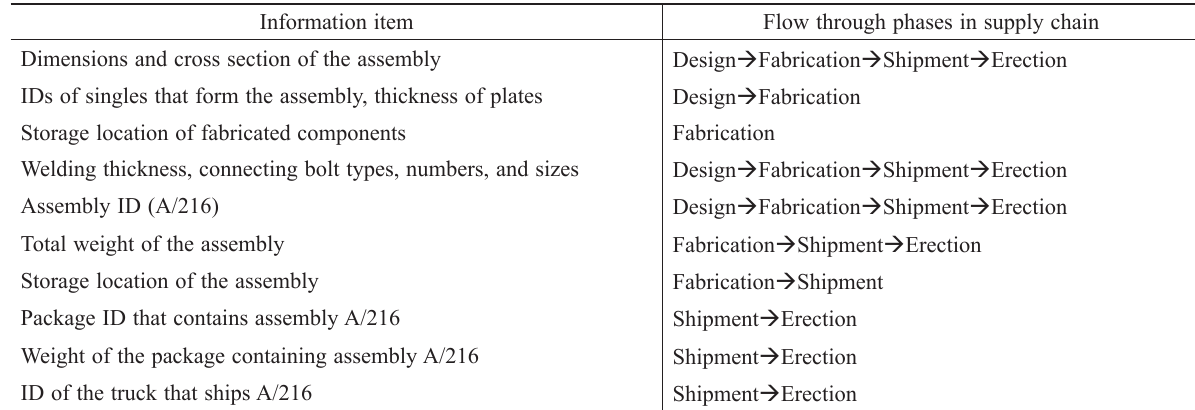
Table 1. Examples of information items generated in relation to assembly A/216 Information